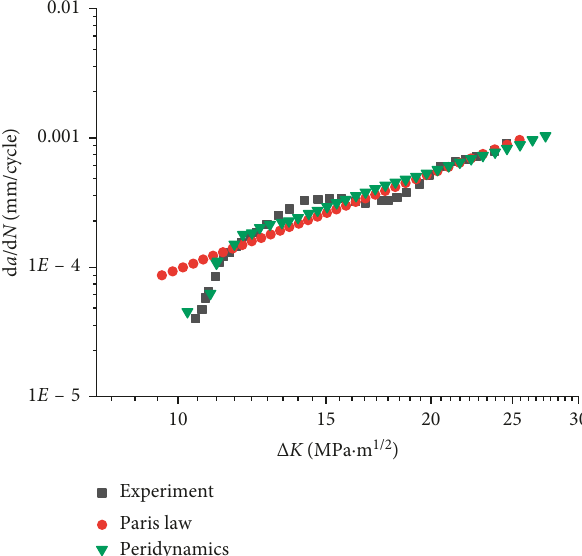
Figure 7: Fatigue crack growth rates of sample